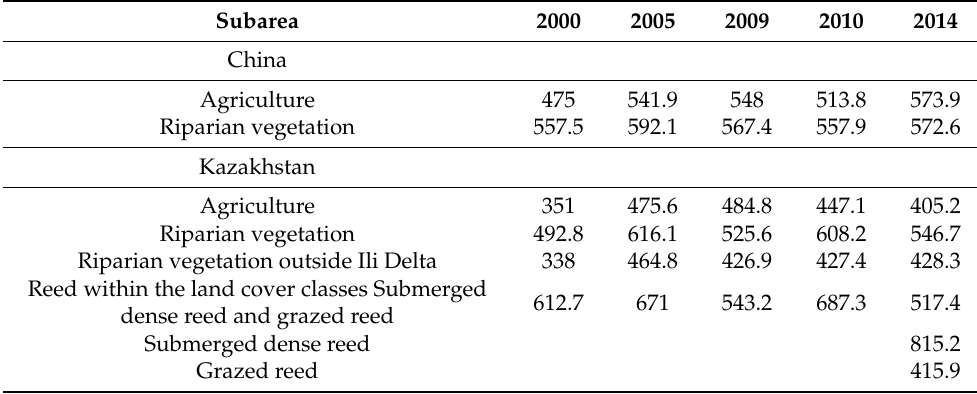
Table 4. Actual evapotranspiration (ET a ) (mm) over the growing seasons of 2000, 2005, 2006, 2010, and 2014 for agriculture and riparian vegetation along the Ili River in China and